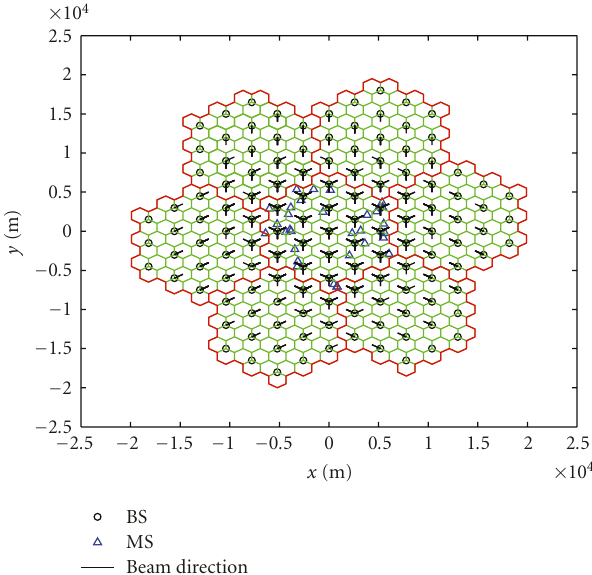
Figure 1: The considered network layout in the simulation.